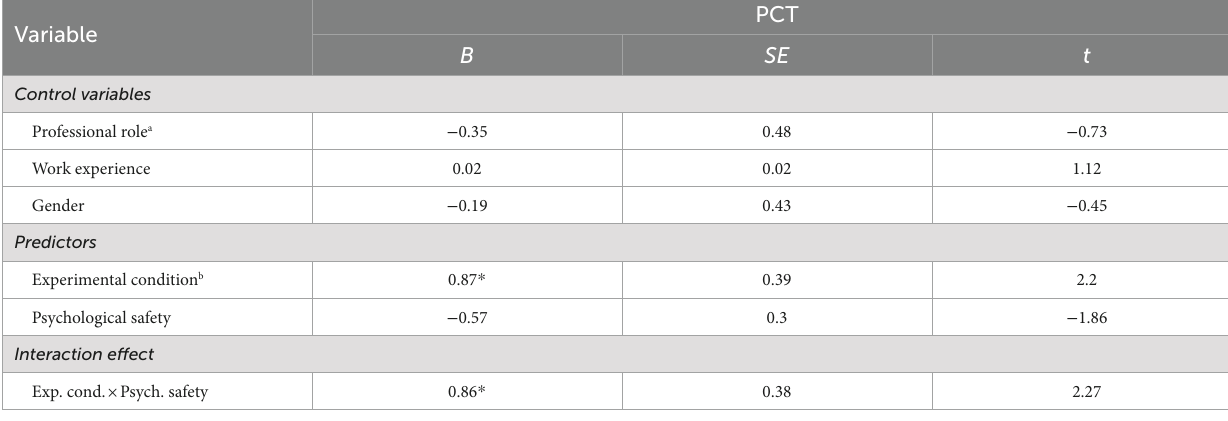
TABLE 2 Moderated multiple regression results predicting perceived contribution to team effectiveness (PCT; including control